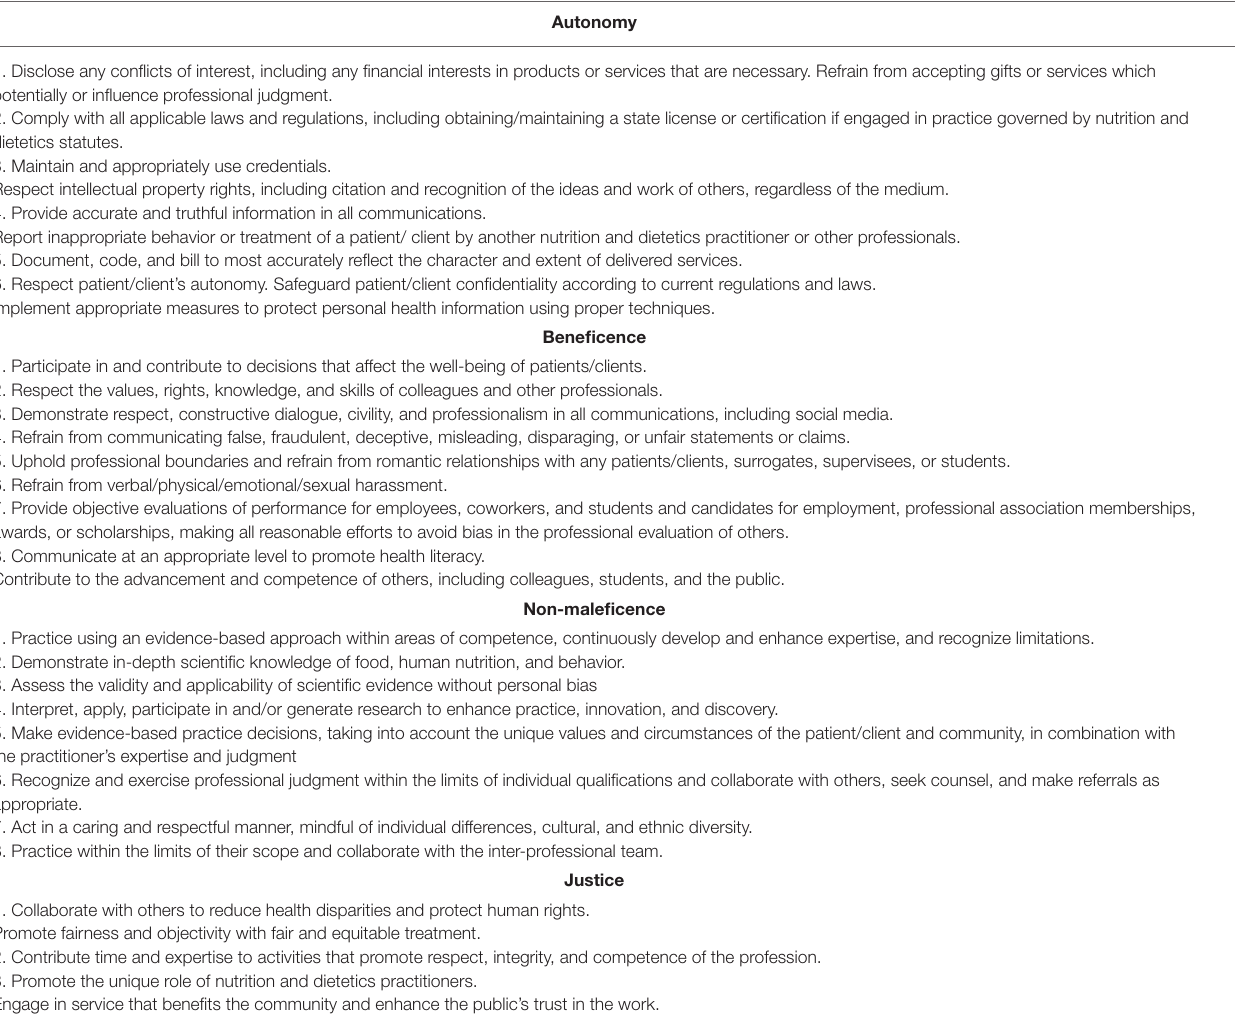
TABLE 2 | According to the academy/CDR code of ethics for the nutrition and dietetics profession in bioethics principles is essential for professionals in the nutrition area (39).